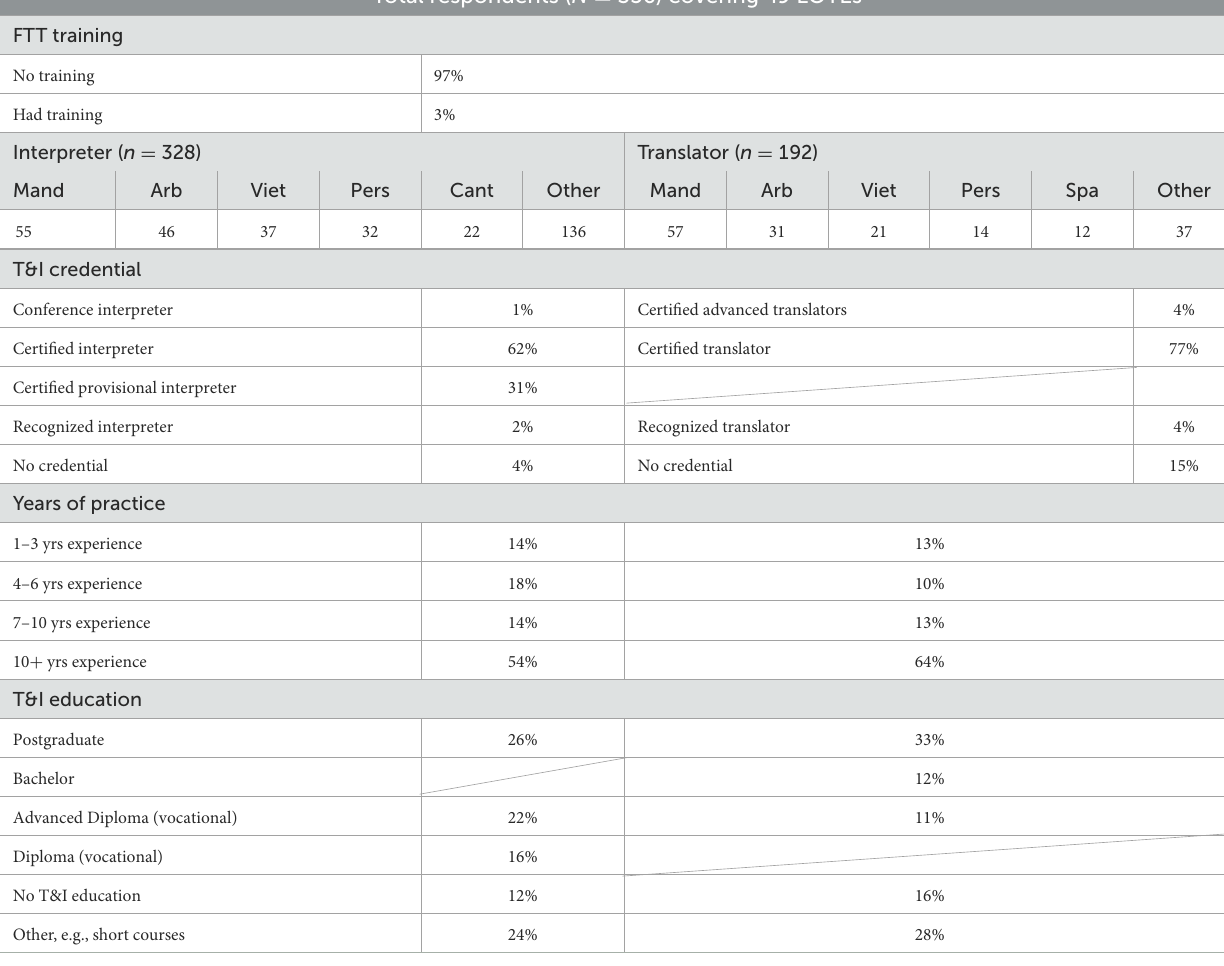
TABLE 3 Summary of respondent demography.